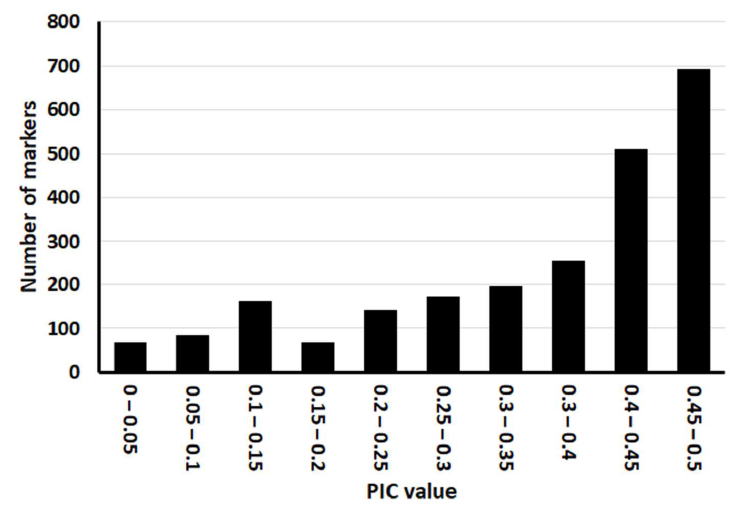
Figure 2. Polymorphism information content (PIC) values of SNP markers present on the target capture